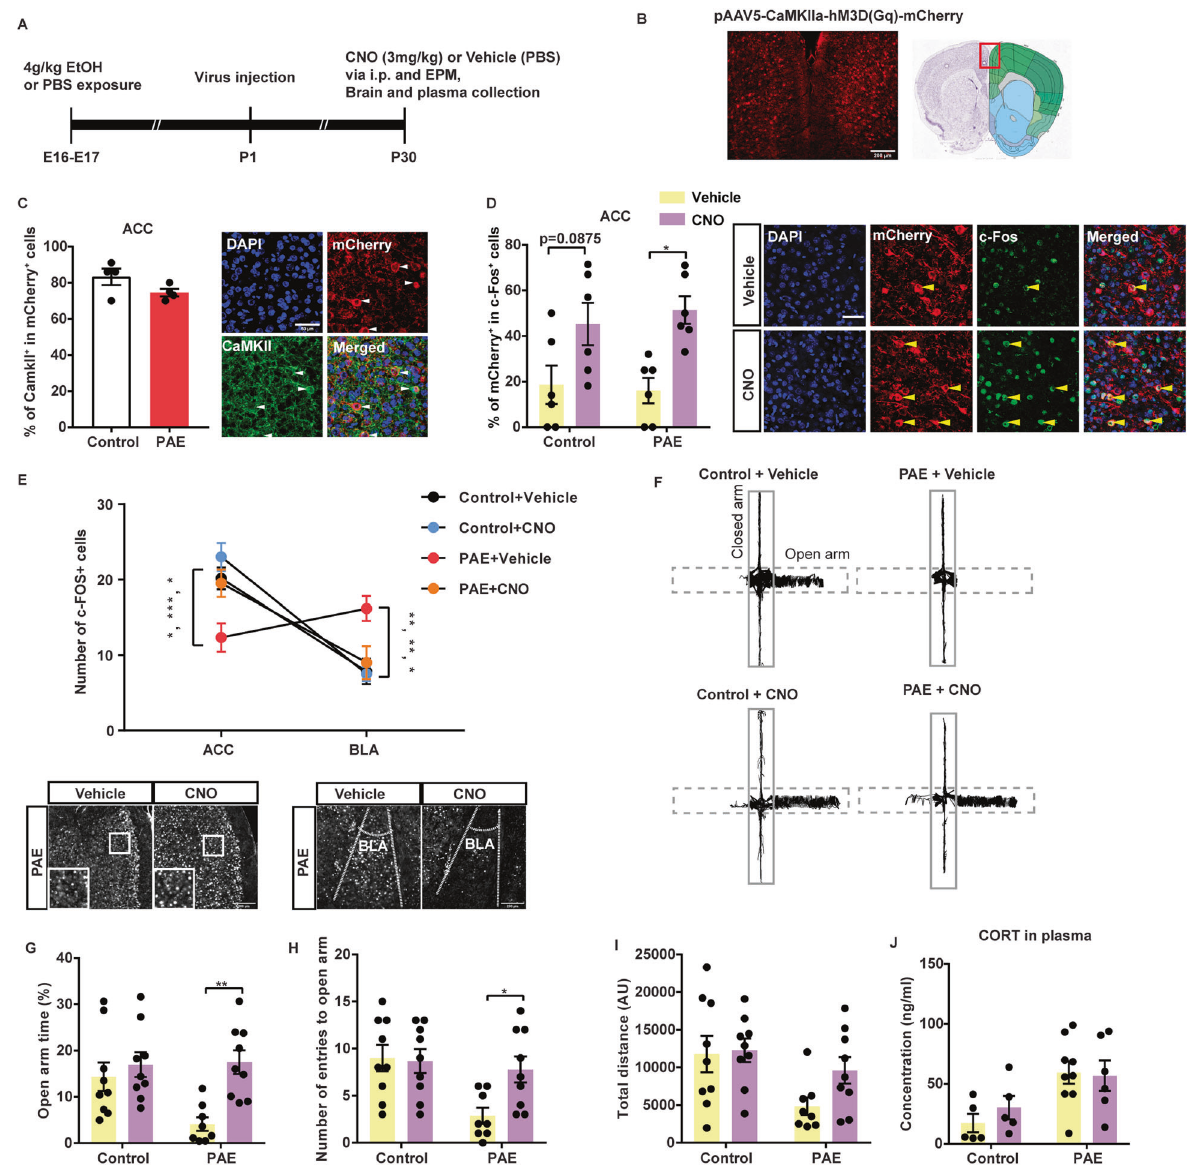
signi fi cant difference between CNO- and